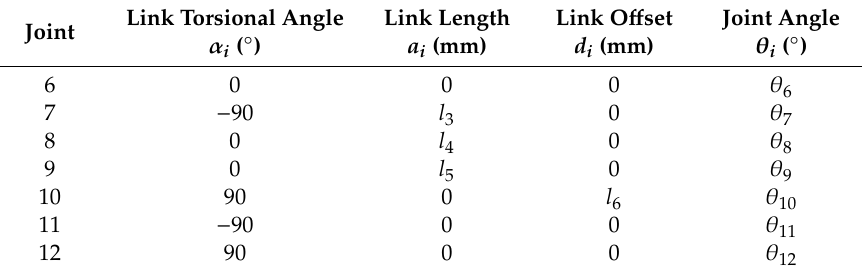
Table 2. D–H parameters of the